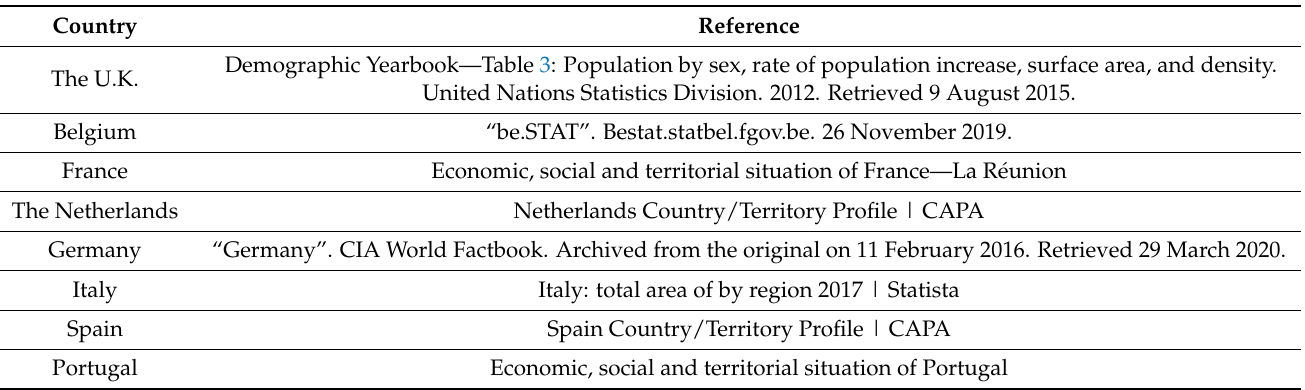
Table A3. Main industrial countries around Belgium. Reference Demographic Yearbook—Table 3: Population by sex, rate of population increase, surface area, and The U.K.